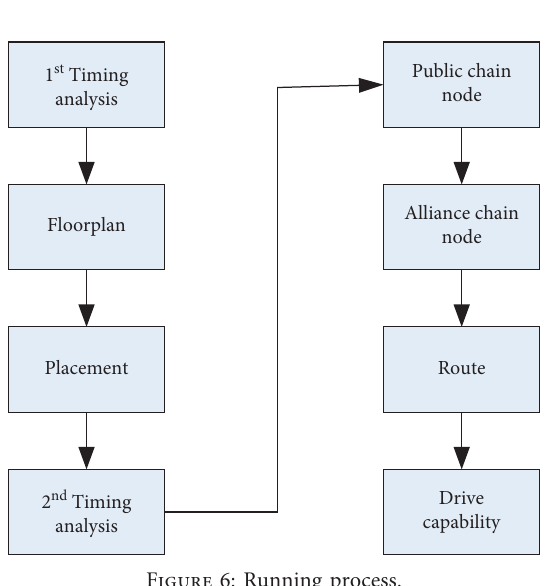
Figure 6: Running